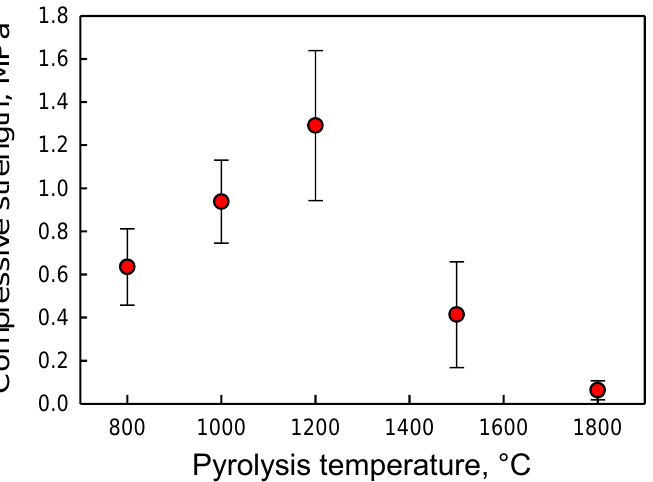
Figure 1. Compressive strength of the SiC foam disks as a function of the pyrolysis temperature.